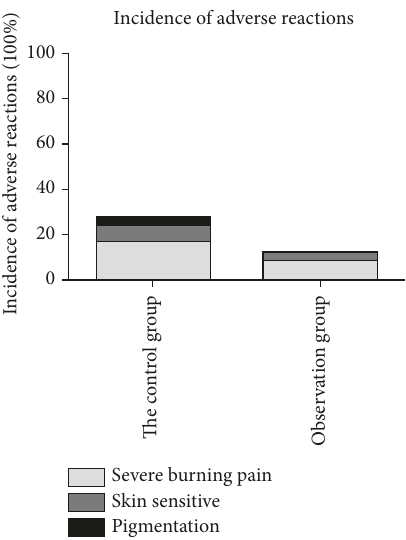
Figure 6: Comparison of the incidence of adverse reactions be- tween the two groups ( χ 2 � 2.498, P > 0 .